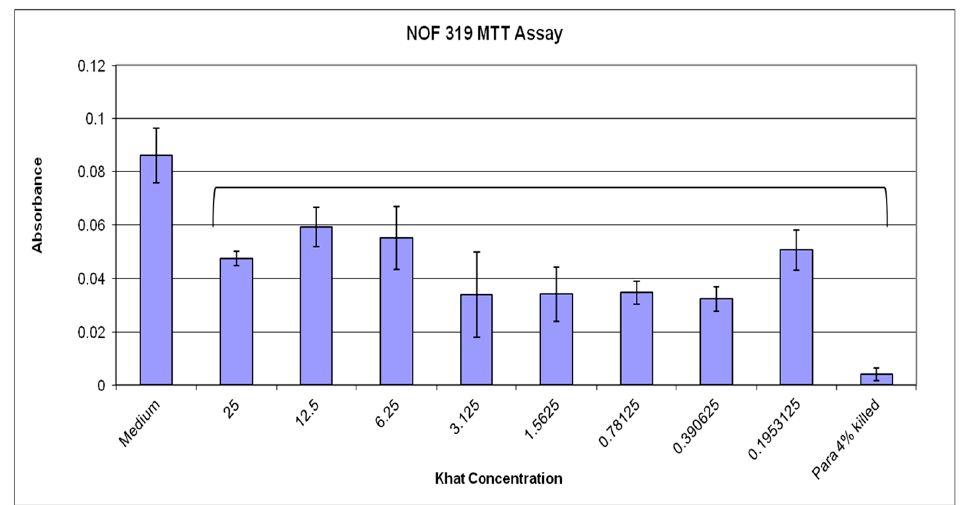
Figure 3. Absorbance from MTT Assay for NOF 319 cells treated with different concentrations of Khat solution (25 mg/mL to 0.195 mg/mL). Medium with only NOF 319 was used as a negative control, while 4% paraformaldehyde was used as a positive control showing complete cell death.